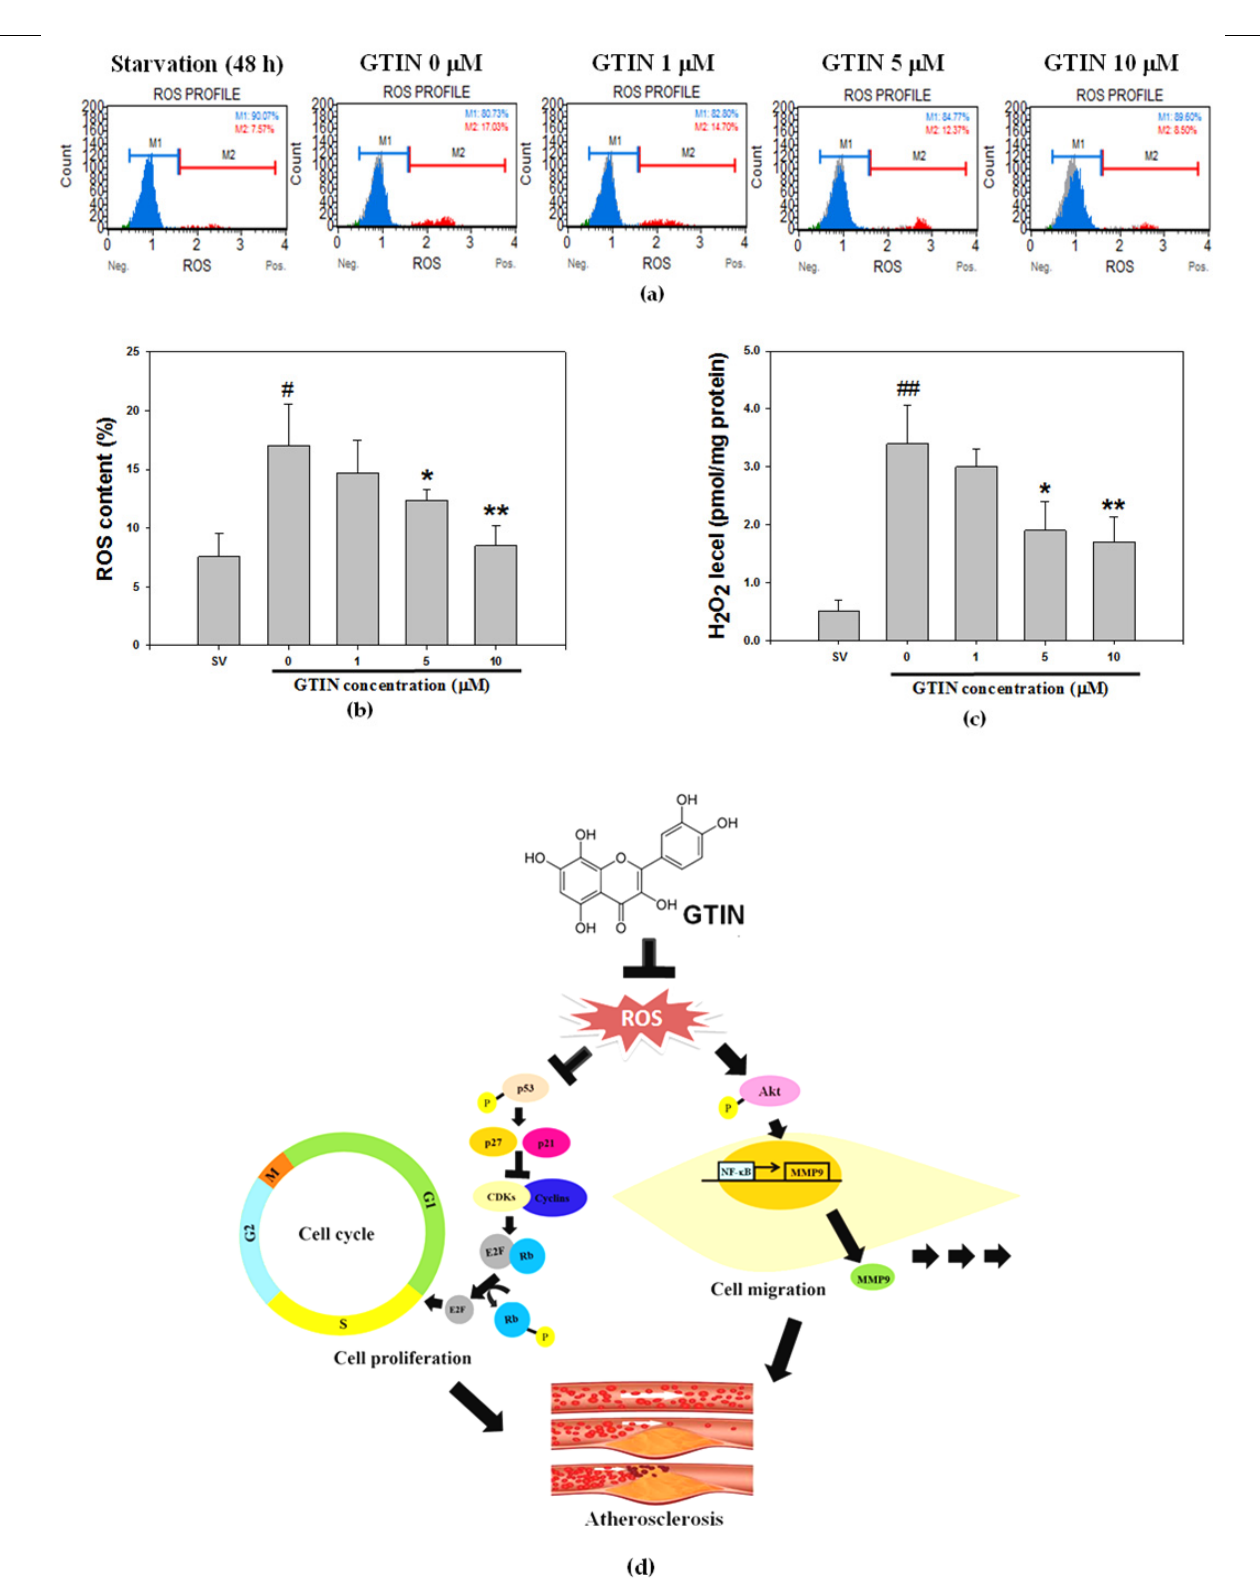
Figure 6. GTIN reduced cellular ROS generation in VSMCs. A7r5 cells were incubated with GTIN at the indicated doses (1, 5 and 10 µ M) for 48 h. ( a ) The cells after treatment were labeled with DCF-DA, and ROS production was detected by measuring Muse™ Cell Analyzer. M1 and M2 respectively display DCF-negative and DCF-positive cell populations. ( b ) Quantitative assessment of the percentage of M2 was showed as means ± SD of three repeats from three